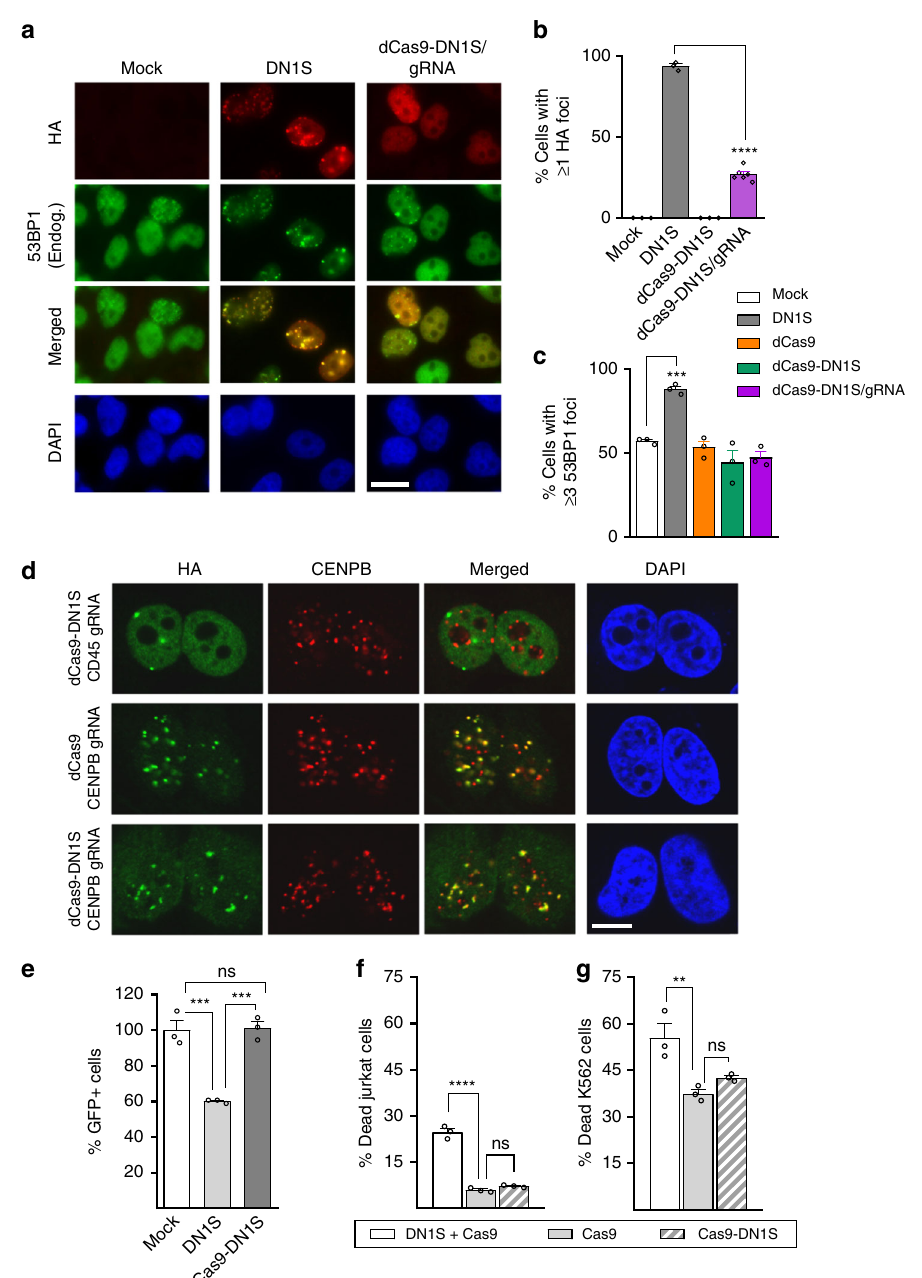
Fig. 2 Cas9-DN1S blocks NHEJ locally, reducing toxicity associated with global NHEJ inhibition. a Representative immuno fl uorescence (IF) images showing HA-tagged DN1S or dCas9-DN1S/gRNA and endogenous 53BP1 recruitment to DNA repair foci. Scale bar represents 20 μ m. b Quanti fi cation of the number of cells with ≥ 1 HA + (DN1S) foci. c Quanti fi cation of the number of HeLa cells with ≥ 3 53BP1 + foci transduced with lentivirus for the following: mock (empty vector), DN1S, dCas9, dCas9-DN1S, and dCas9-DN1S/gRNA. b , c the data are presented as the mean ± SEM of three counts of 150 cells each from independent fi elds, except dCas9-DN1S/gRNA in b , which shows six counts of 150 cells from independent fi elds. Black circles indicate individual counts. Statistics: ANOVA, *** p < 0.001, **** p < 0.0001. d Representative IF images showing co-localization of dCas9 or dCas9-DN1S with CENPB gRNA to CENPB in centromeres. dCas9-DN1S with CD45 gRNA was used as a control. Scale bar represents 10 μ m. e GFP + HeLa cells with stable integration of the EJ5-GFP NHEJ reporter, after exposure to lentiviral constructs expressing DN1S or Cas9-DN1S, and lipofection with the I-SceI plasmid. I-SceI induced DSB repair via NHEJ at de fi ned sites in the reporter allows for GFP expression. GFP + cells were quanti fi ed by fl ow cytometry and data normalized to GFP + cells in mock controls. Viability of ( f ) Jurkat cells and ( g ) K562 cells 48 h after DN1S or empty vector transduction, and 24 h after Cas9 or Cas9-DN1S RNP electroporation with AAV donor template delivery. Viability was quanti fi ed by fl ow cytometry using eFluor 780 fi xable viability dye. a – e Cas9 denotes SpCas9. f – g Cas9 denotes SaCas9; e – g data are presented as the mean ± SEM of three independent transfections or electroporations. Black circles indicate individual data points. Statistics: ANOVA. ns indicates not signi fi cant, ** p < 0.01, *** p < 0.001, **** p < 0.0001. Source data is available in Source Data fi